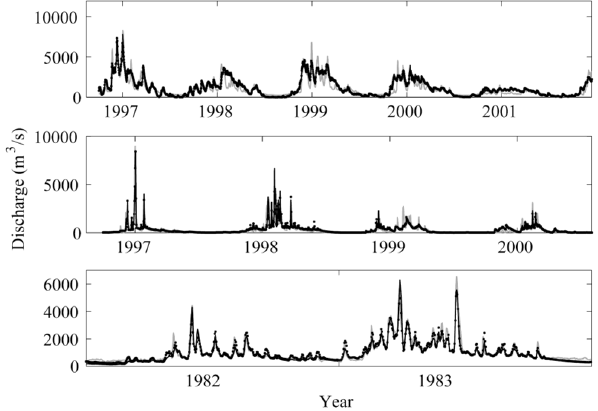
Fig. 7. Observed (gray lines) and best simulated discharge with the TRG algorithm (black lines), and the VIC algorithm (black dots) for the Willamette River basin at Portland (top), the Eel River basin at Scotia (middle), and the Dongjiang River basin at Boluo